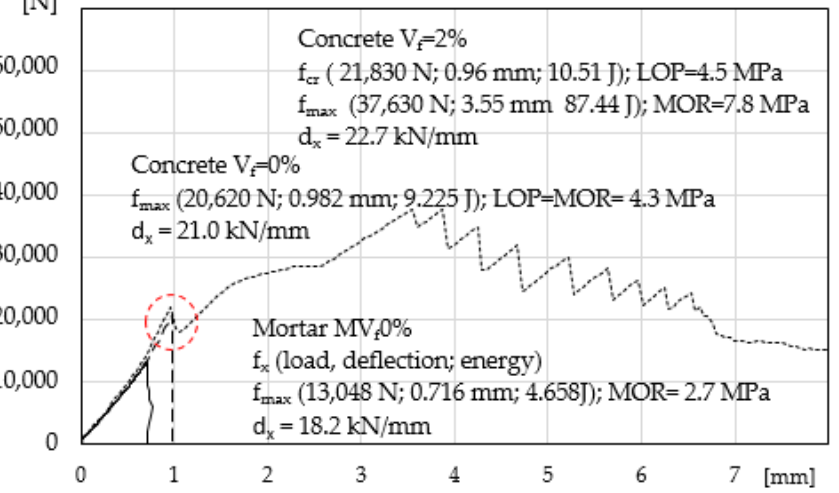
Figure 4. Load-deflection curve in the four-point bending test, mortar MV f 0% (matrix) and concrete without fibres V f = 0% and with V f = 2% fibres.